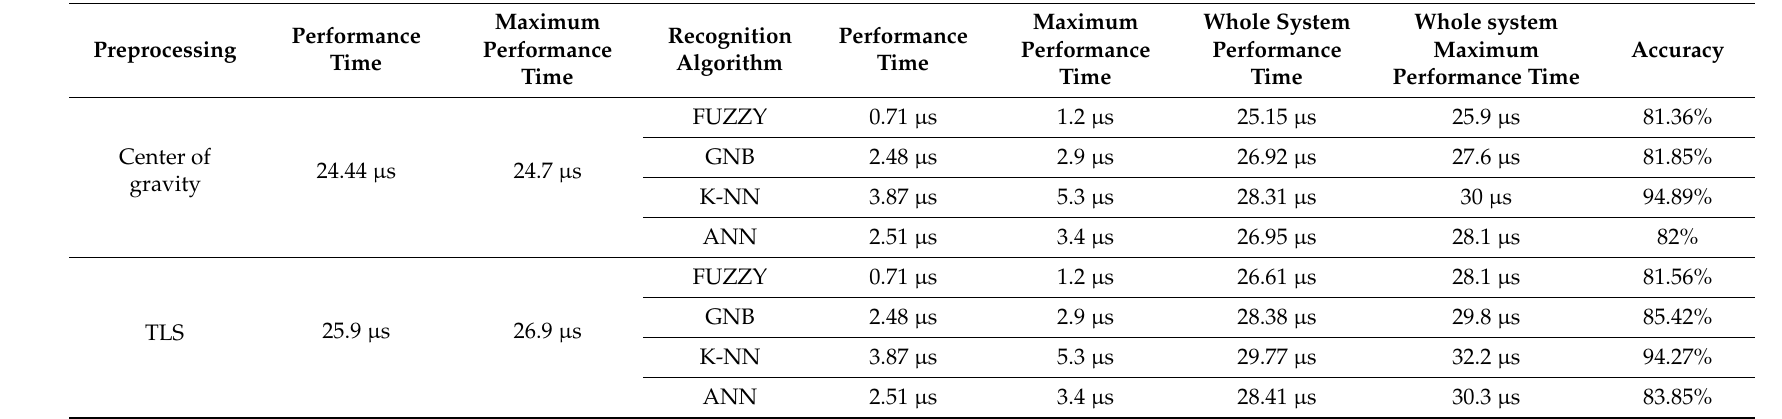
Table 1. Performance evaluation with Raspberry Pi